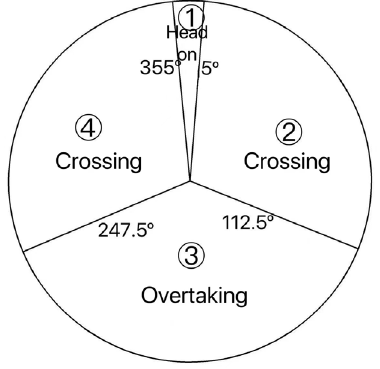
Figure 1. Classification of the ship encounter situation.